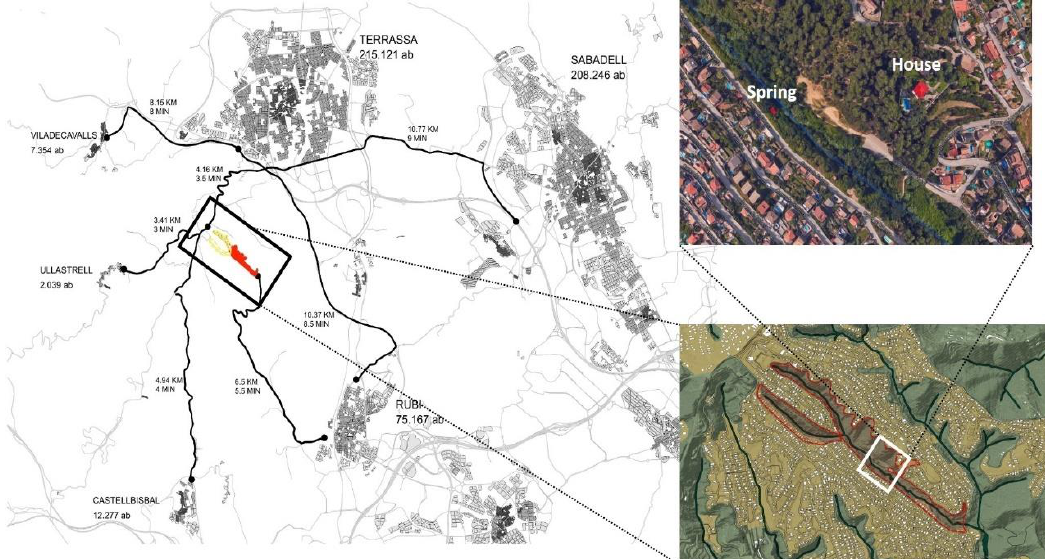
Figure 1. Location where the study site was conducted (valley of “Les Martines” in Rubí (Catalonia, Spain); source: Landscape Intervention and Heritage Management (LIHM) students). Yellow indicates the initiation of the stream; red indicates the area of study.